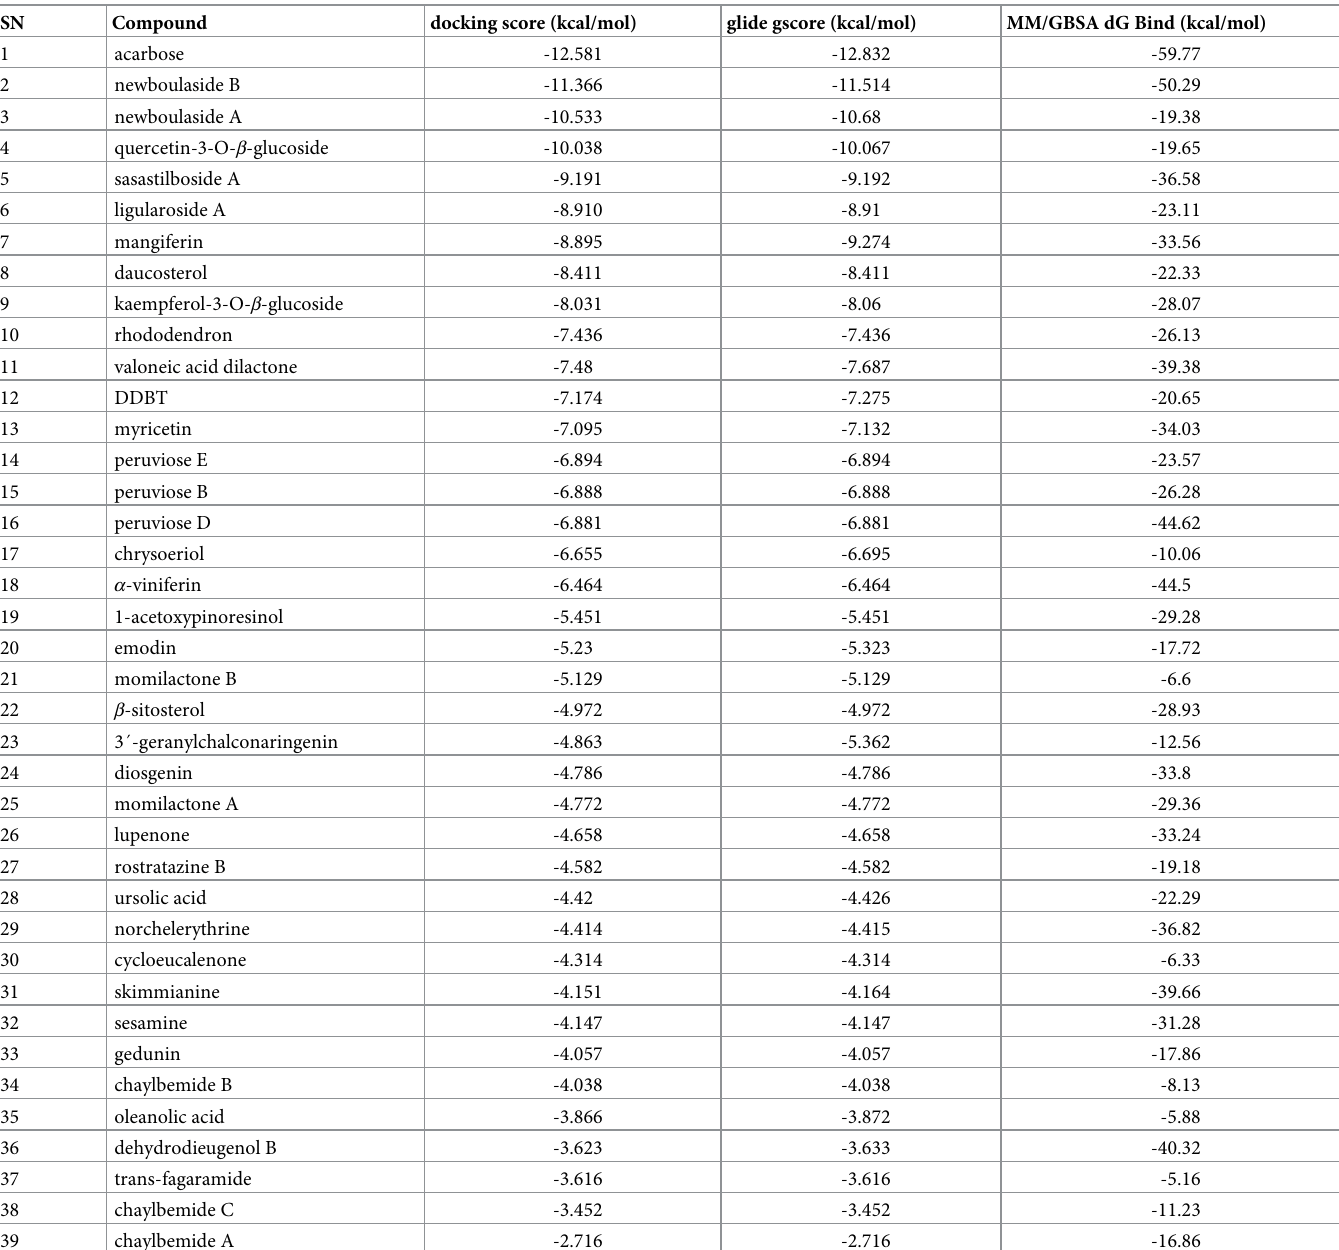
Table 1. Glide molecular docking and MM/GBSA binding energy of